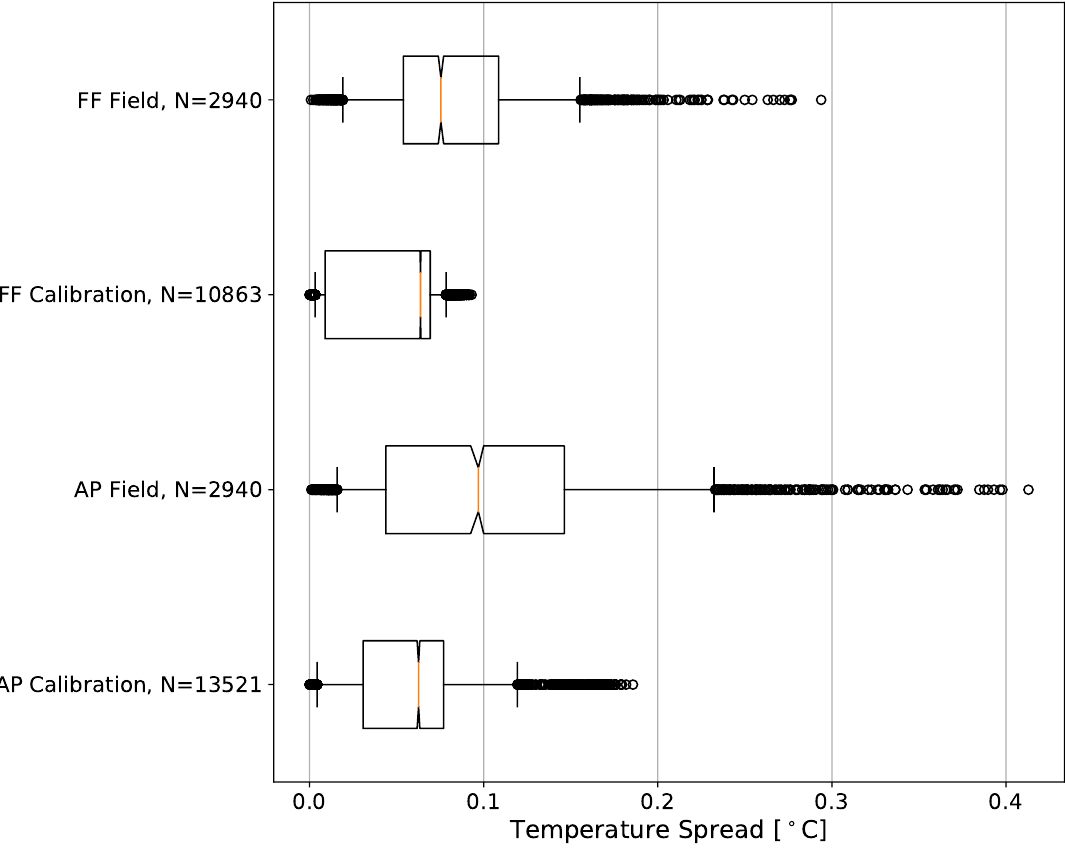
Figure 5. Notched box and whisker plots of temperature mean of absolute differences [ ◦ C] distributions from the different sensor configurations calculated using Equation (1). The 25th, 50th, 75th are represented by the boxes, and the 5th and 95th percentiles are represented by the whiskers. Samples outside the 5th–95th percentiles are plotted individually as circles. The notches estimate the 95% confidence interval of the median using a bootstrap method with 10,000